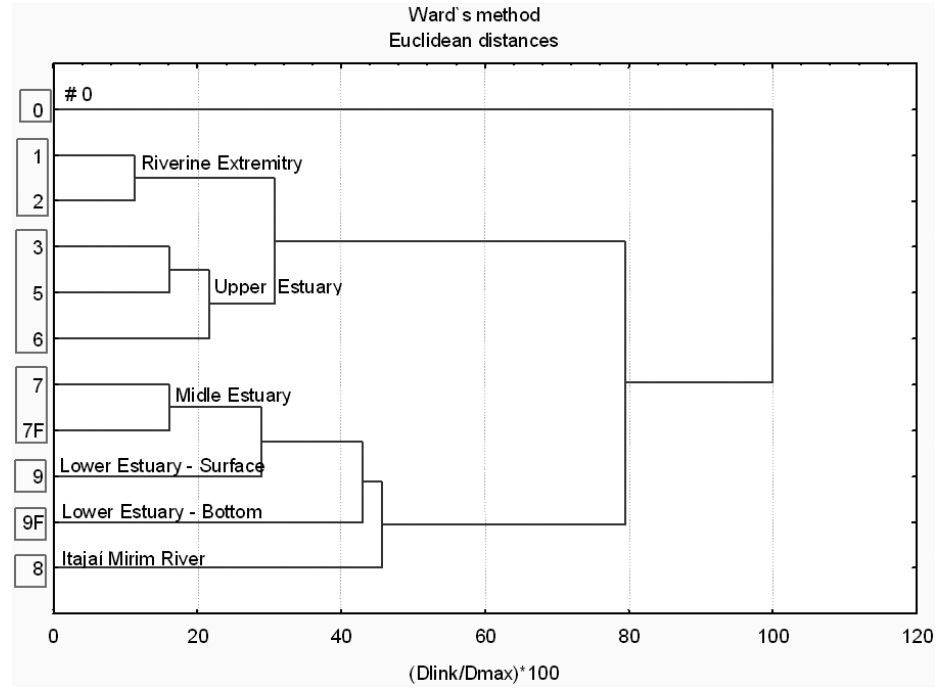
Fig. 6 – Dendrogram showing the clusters formed based on the cluster analysis carried out on the measurements of variables in each collection station, in the Itajaí-Açú River estuary. The clustered stations correspond to the compartments of the estuary, from its fluvial extremity in the municipal district of Indaial (station 1), to the river mouth (station 9). The station #0 was also